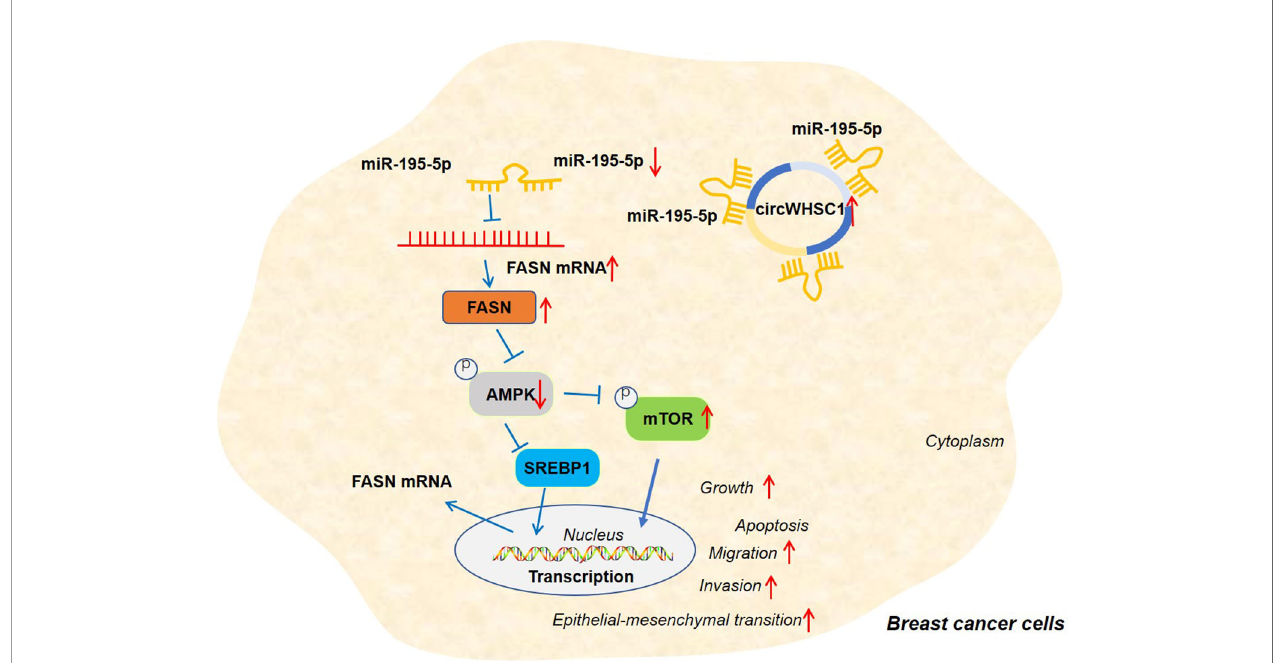
FIGURE 9 | The graphical abstract of the circWHSC1-miR-195-5p-FASN/AMPK/mTOR axis on BC development. circWHSC1 is up-regulated in BC. CircWHSC1 targets miR-195-5p, which inhibits FASN expression. FASN induces inhibitive effects on the AMPK pathway, thus enhancing proliferation, growth, migration, invasion, EMT and relieving